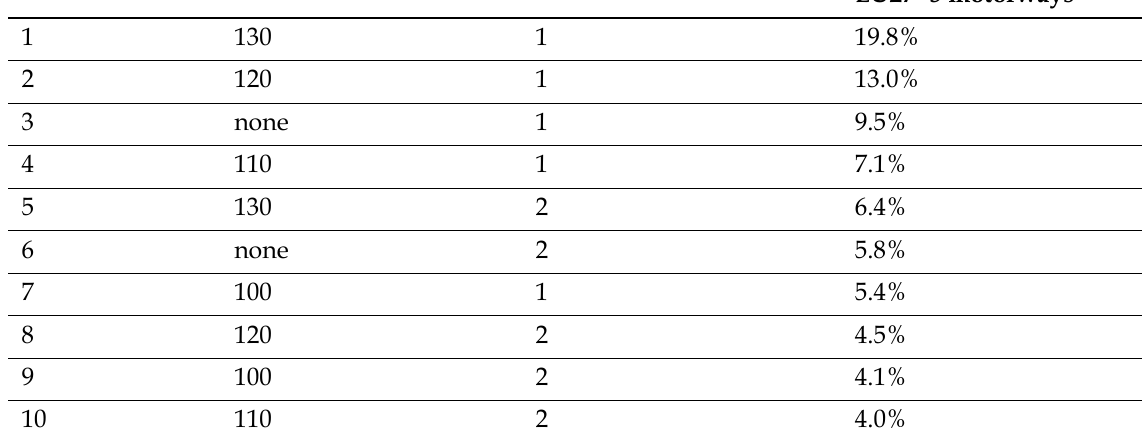
The ten most common speed limit and traffic volume combinations on EU27+3 motorways (representing 79.6% of VKT). Volume class 1: up to 750 veh/h/lane; 2: 751–1250